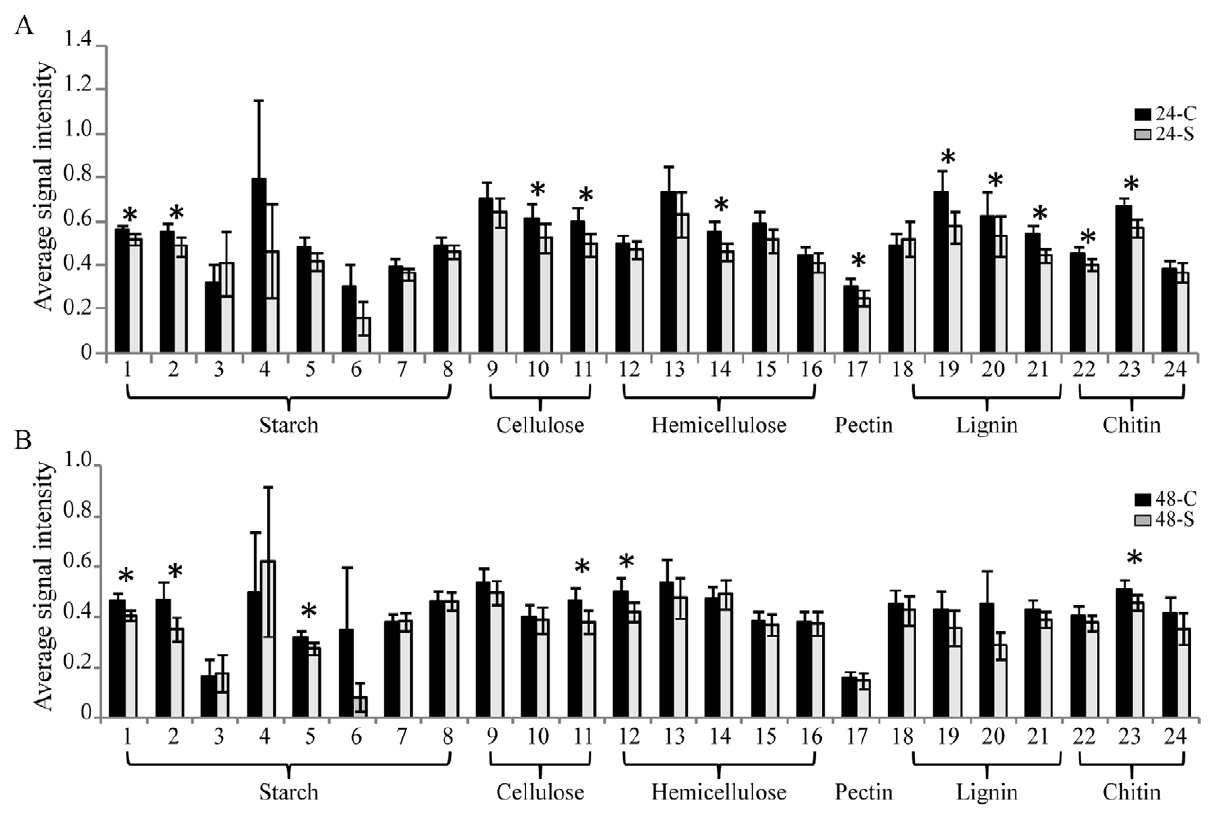
Figure 4. The impacts of EcO157 on genes involved in carbon degradation in spinach biofilm communities. Panels A and B are biofilms at 24 h and 48 h, respectively. The abundance of each gene is expressed as the average signal intensity of all gene probes detected for that gene in each biofilm community. Error bar represent the standard error of the mean for each gene. Genes with a significant decrease in the abundance between the control- and the EcO157-inoculated biofilm communities were marked with an asterisk (*) (t test, P , 0.05). Starch degradation: 1, a - amylase ( amyA ); 2, glucoamylase; 3, amylopullulanase ( amyX ); 4, amylopullulanase ( apu ); 5, pullulanase ( pulA ); 6, isopullulanase; 7, neopullulanase II ( nplT ); 8, dextrin-hydrolase ( cda ). Cellulose degradation: 9, endoglucanase ( egl ); 10, exoglucanase; 11, cellobiase or b -glucosidase ( bgl ). Hemicelluloses degradation: 12, bacterial arabinofuranosidase ( ara ); 13, fungal arabinofuranosidase ( ara ); 14, mannanase; 15, xylose isomerase ( xylA ); 16, xylanase. Pectin degradation: 17, pectinase. Lignin degradation: 18, glyoxal oxidase ( glx ); 19, ligninase ( lip ); 20, manganese peroxidase ( mnp ); 21, phenol oxidase ( lcc ). Chitin degradation: 22, acetylglucosaminidase; 23, endochitinase; 24, exochitinase.